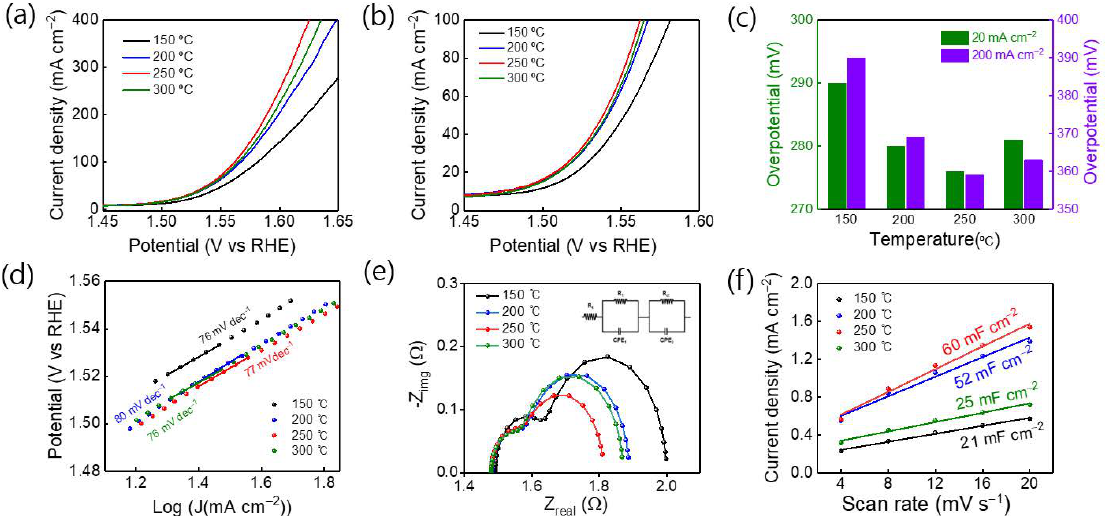
Figure 6. ( a , b ) LSV curves (85% IR -compensated) and ( c ) overpotentials at various current densities for CCO catalysts (150, 200, 250, and 300 ◦ C) in 1 M KOH at room temperature. ( d ) Tafel plots, ( e ) EIS results, and ( f ) C dl of CCO catalysts (150, 200, 250, and 300 ◦